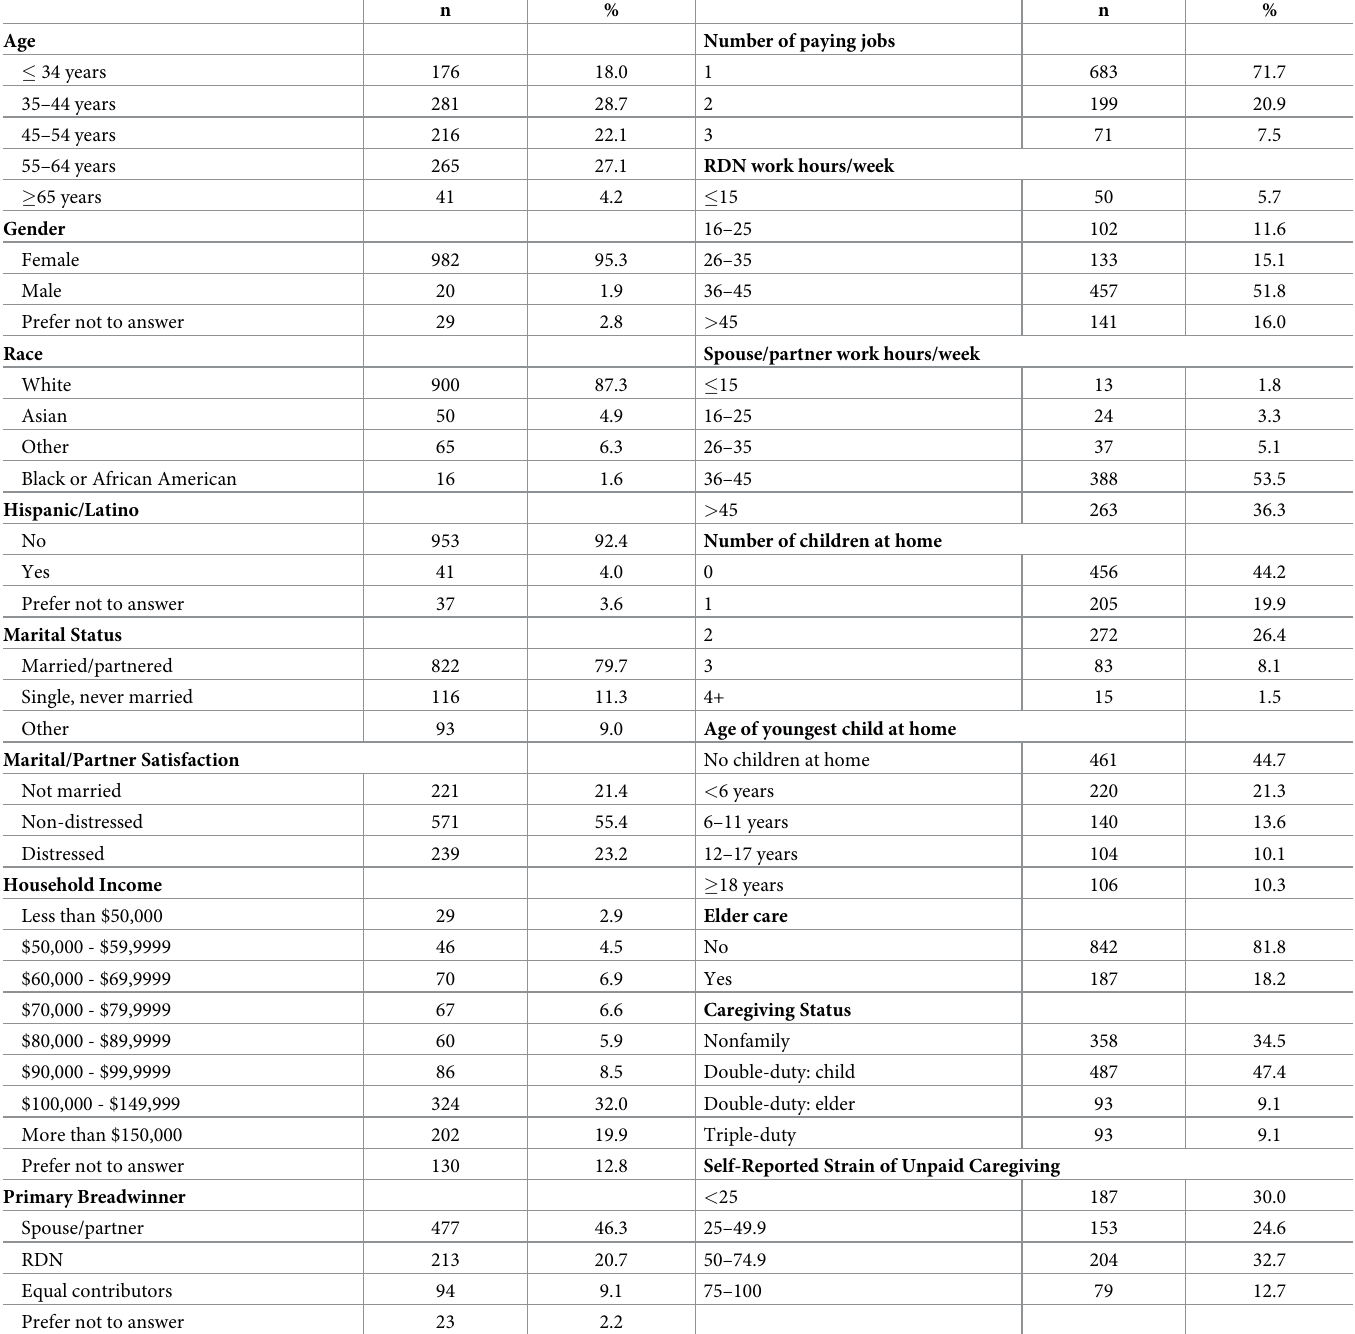
Table 1. Registered Dietitian Nutritionists’ (RDN) personal and family characteristics (n =